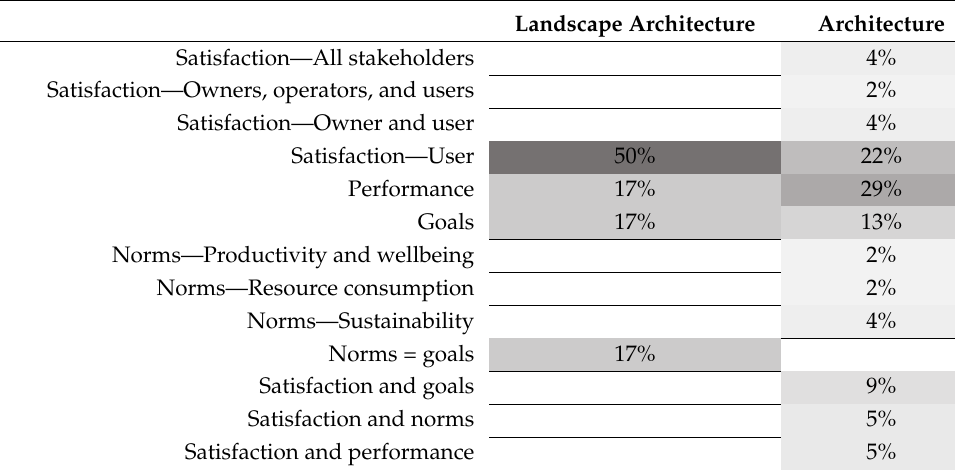
Table 3. The proportion of the models’ adoption in landscape architecture and architecture (according to the model adopted by collected definitions). Landscape Architecture Architecture Satisfaction—All stakeholders 4% Satisfaction—Owners, operators, and